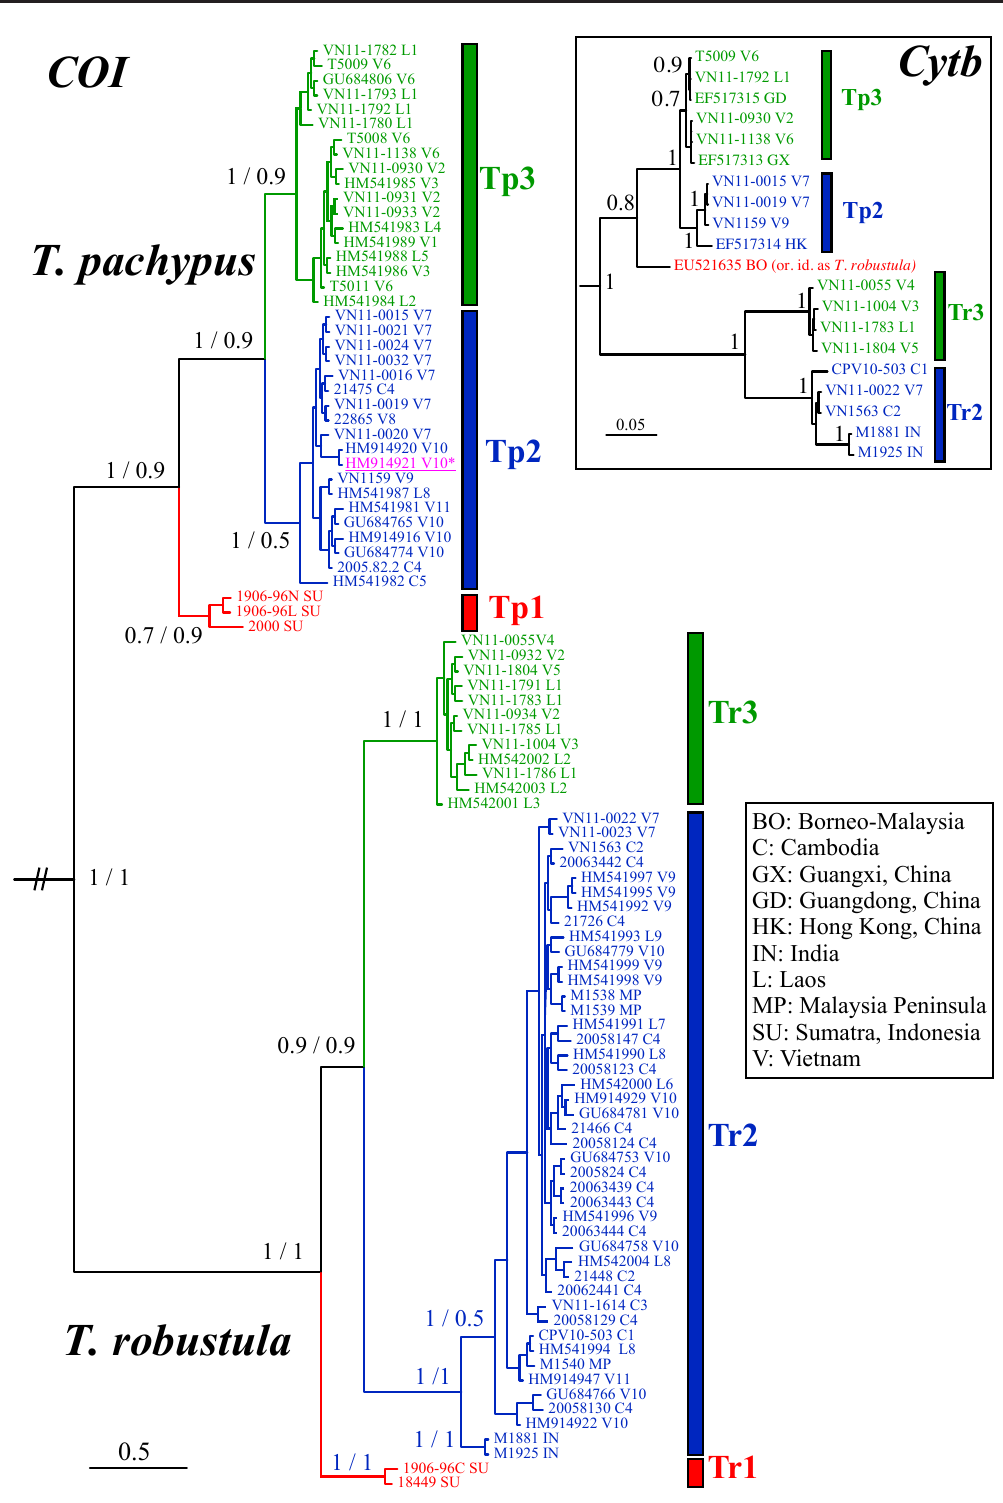
Fig. 2. Bayesian tree obtained from the analyses of COI and Cytb genes. The values on the nodes indicate posterior probabilities (PP). In the COI tree, PPs were calculated from two DNA alignments of CO1 sequences (728 nt or 291 nt; see text for details). The sequence HM914921 was obtained from a specimen originally identified as T. robustula . In the Cytb tree, the sequence EU521635 was obtained from a specimen originally identified as T. robustula